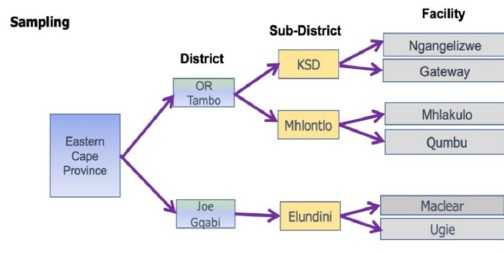
Figure 2. Study sampling and site.